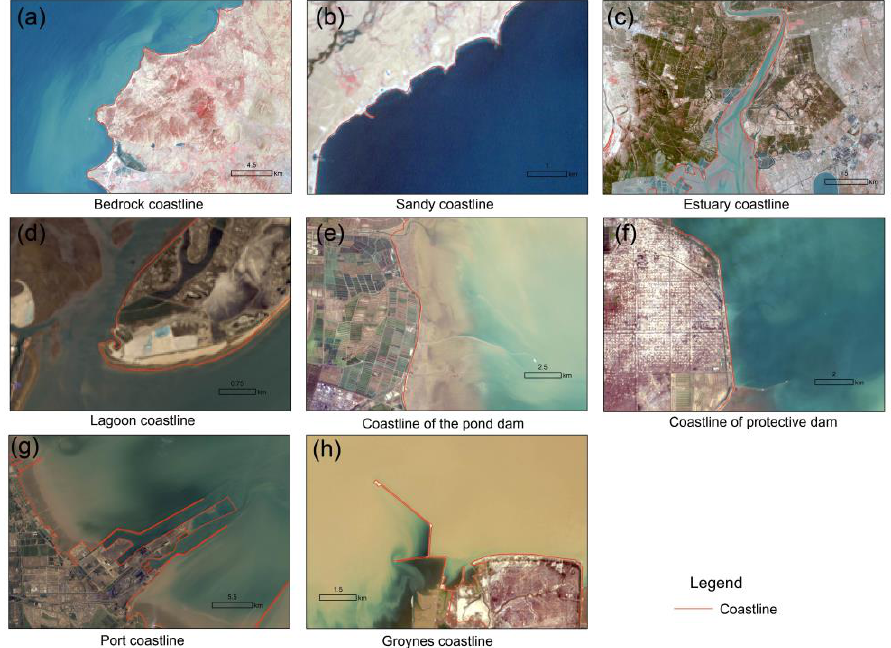
Figure 3. Coastline interpretation. ( a ) Jiutou Mountain, located at Dalian City; ( b ) A band of sand deposits that are parallel to the coastline; ( c ) Daliao River Estuary, located in Liaodong Bay; ( d ) A lagoon barrier coast, located in Bohai Bay; ( e ) A mariculture pond; ( f ) Gudong oilfield, located in the north of the Yellow River Estuary; ( g ) Dongying Part, located in Bohai Bay; ( h ) A 4.5 km curved groyne, connected to the land and aimed to protect it. Port coastline and groynes coastline belong to marine construction coastline.